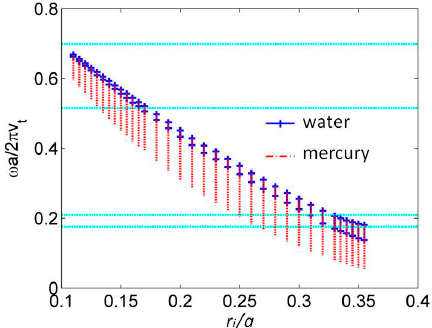
Figure 10. Varied range of WGM 1 frequency when the holes are respectively empty or fully filled with the liquid: water ( blue dotted lines ) and mercury ( red dotted lines ), corresponding to different inner radii. The other geometric parameters are h/a = 0.45, r/a = 0.4, l/a = 0.2. The upper frequency range limited by two horizontal cyan lines is the Bragg band gap of background full PnCs ( h/a = 0.45, r/a = 0.4, l/a = 0) and the lower one is the low frequency band gap.